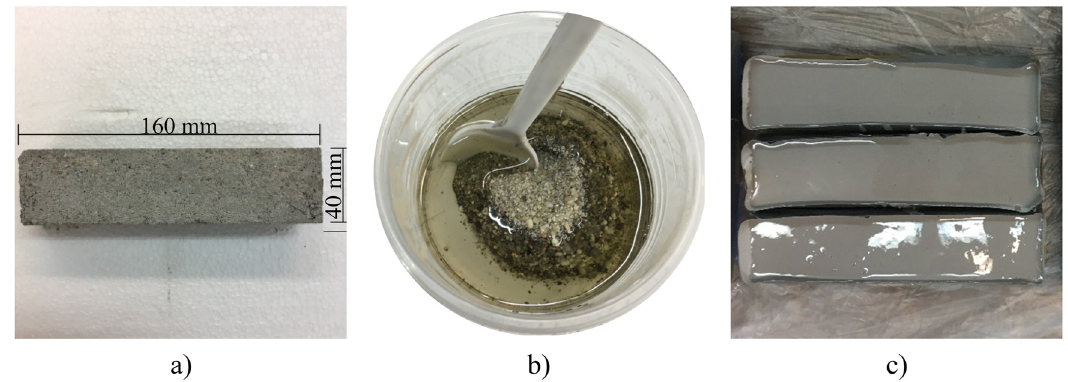
Figure 2: Preparation process of the samples: ( a ) cementitious substrate; ( b ) mixing of epoxy resin components; ( c ) samples after applying epoxy